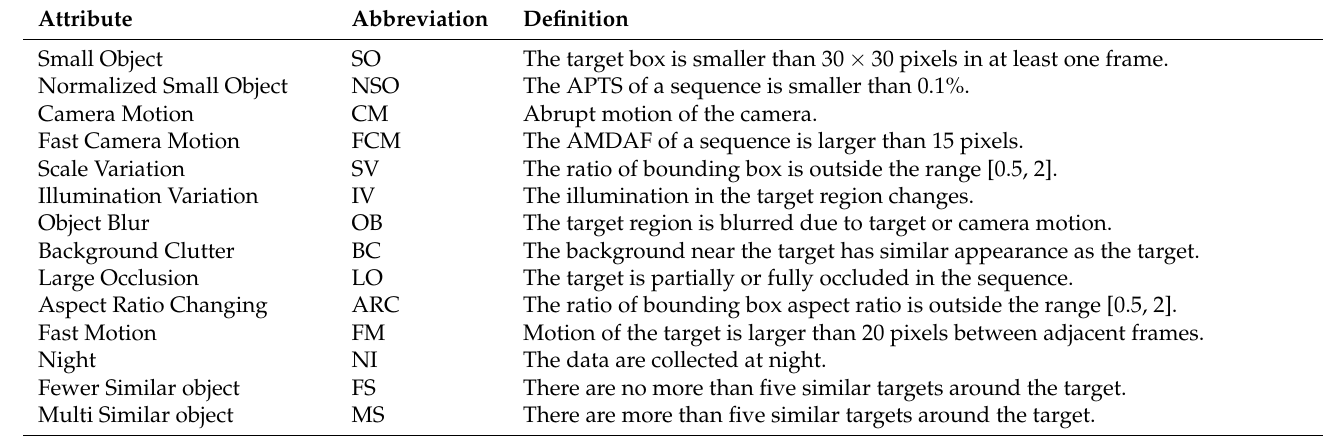
Table 4. Fourteen different attribute definitions in